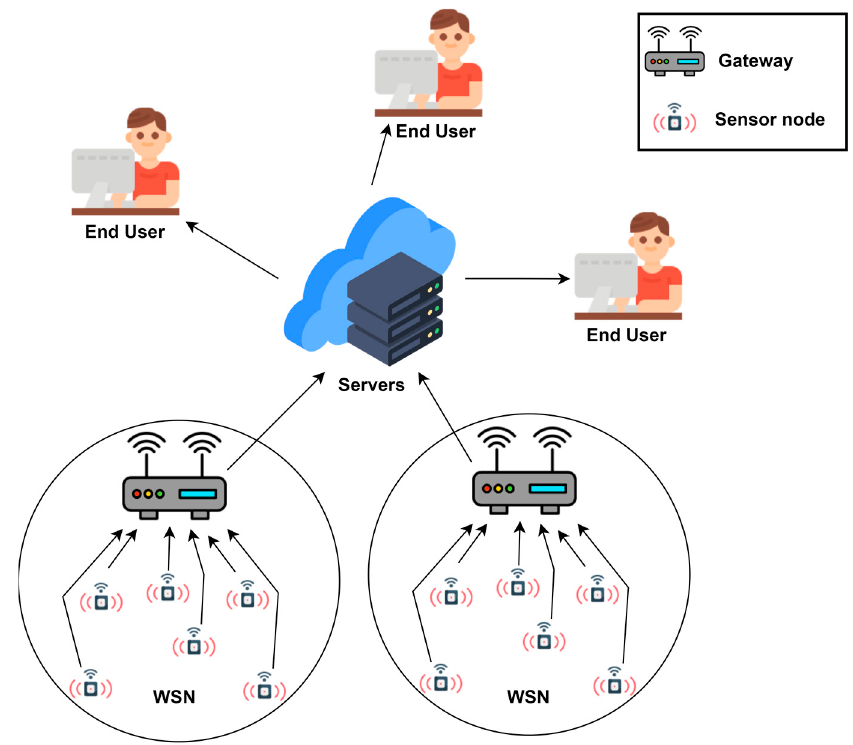
Figure 1. Classic wireless sensor network architecture.